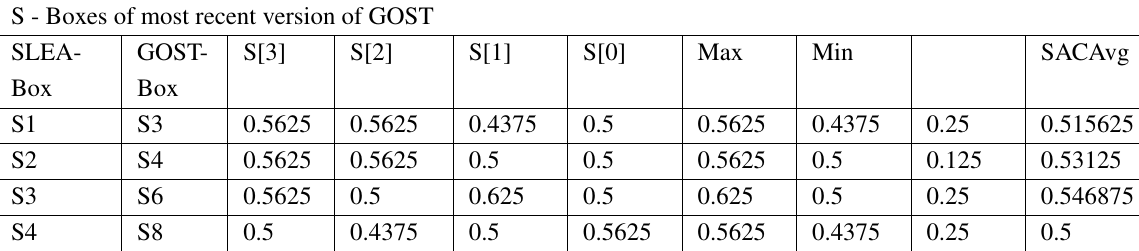
Table 2. The Strict Avalanche Criterion (SAC) of the SLEA